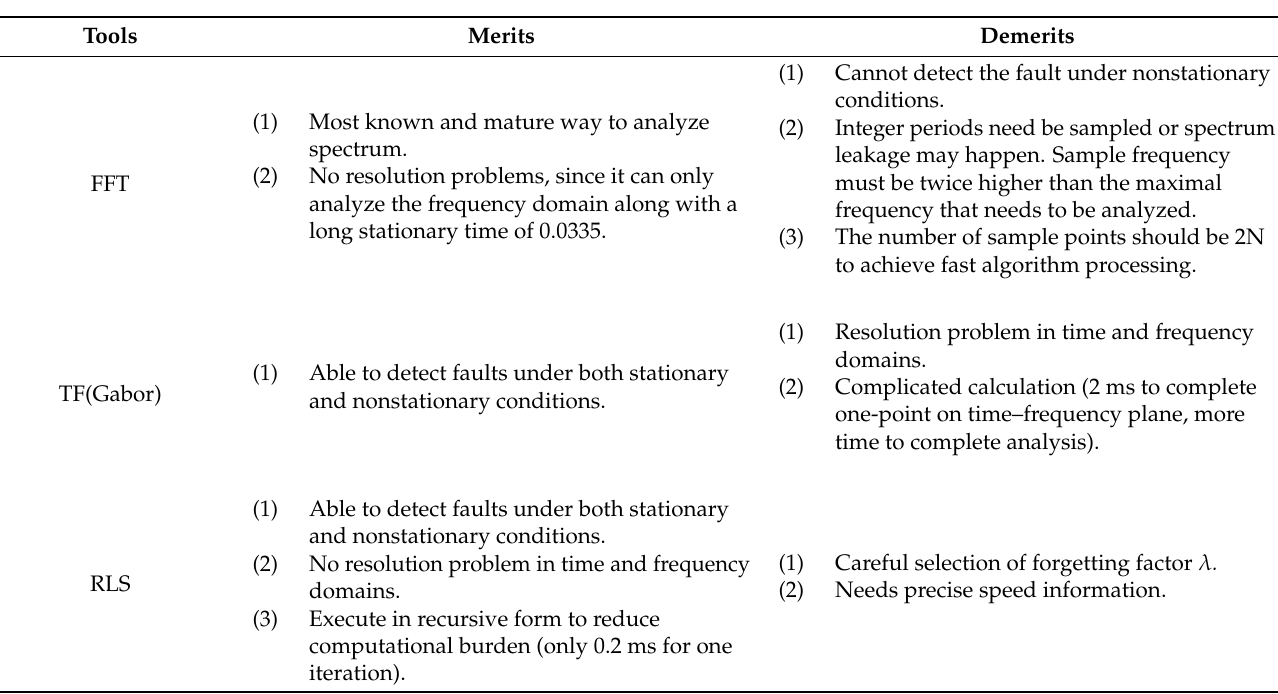
Table 4. Merits and demerits of different analytical